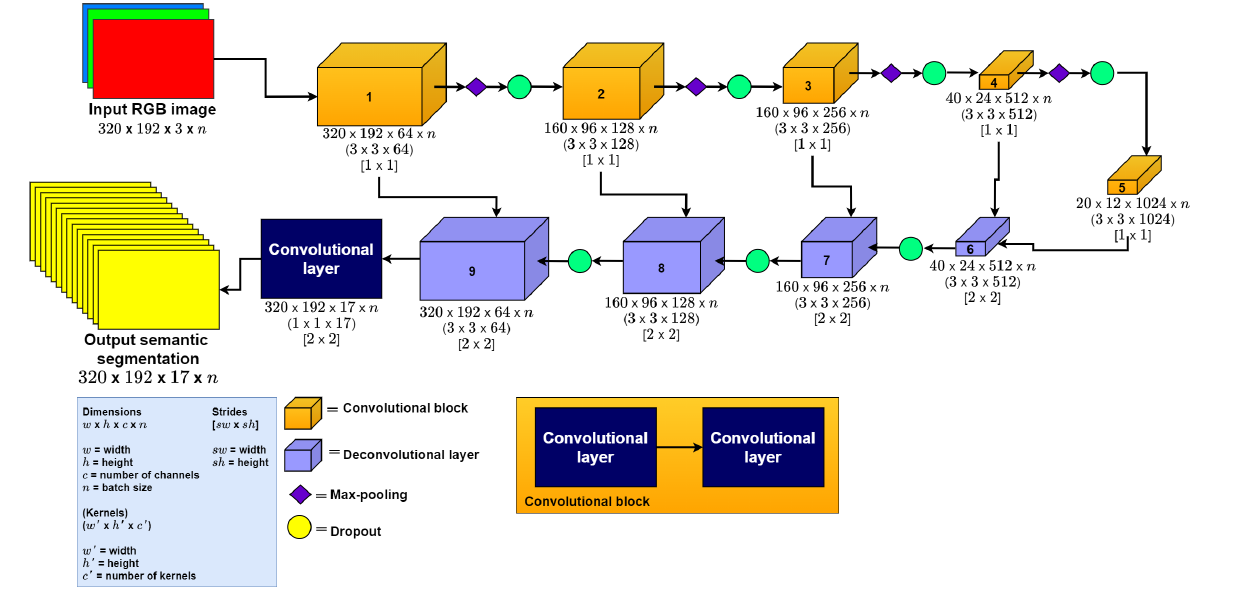
Figure 2. U-Net implementation.